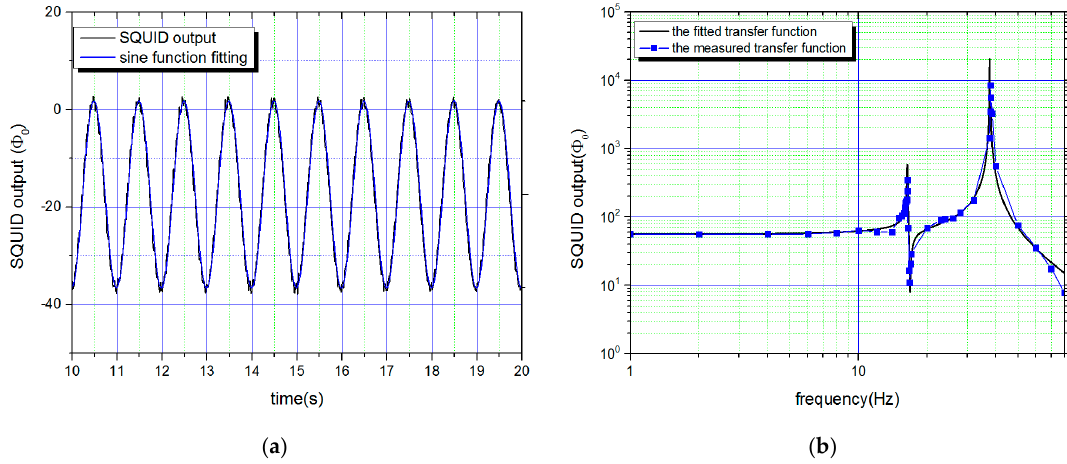
Figure 6. ( a ) The Superconducting Quantum Interference Device output of one test mass under 1 Hz modulation acceleration. The output signal is fitted with a sine function to determine the amplitude. ( b ) The measured and fitted transfer function. The common and differential-modes natural frequencies and the characteristic frequency were all detected, and the characteristic frequency was obtained by the fitted transfer function.